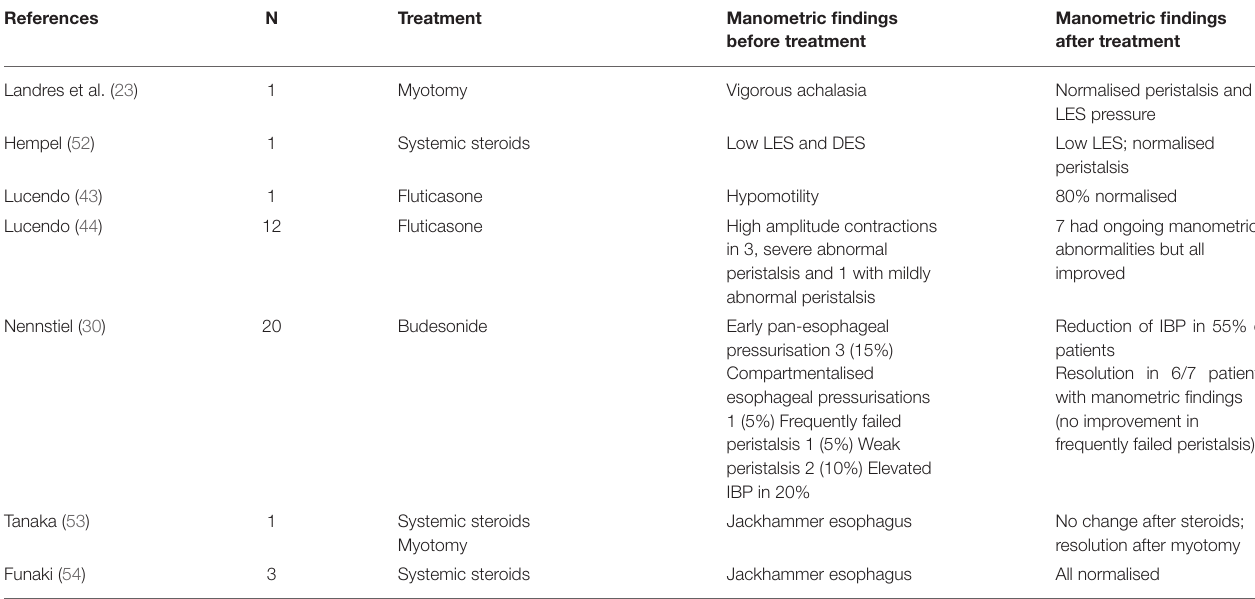
TABLE 3 | Manometry findings before and after eosinophilic esophagitis